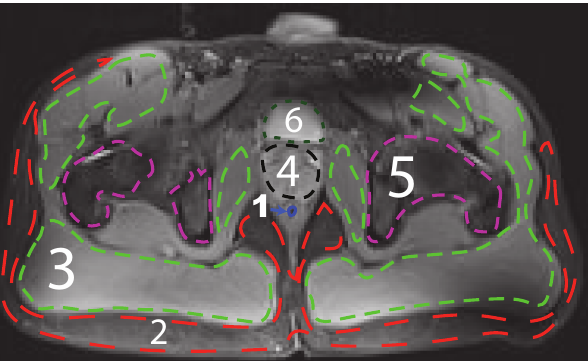
Fig 2. Selected ROIs on a T 1 -weighted image of the pelvic area. 1) air, 2) fat, 3) muscle, 4) prostate, 5) bone marrow, and 6) bladder.